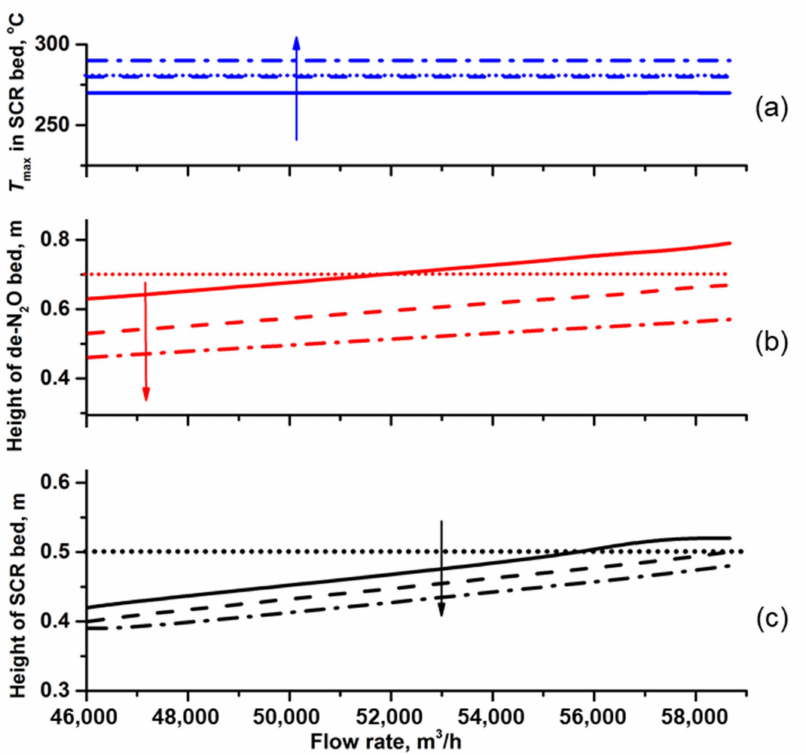
Figure 3. Maximum temperature ( a ), height of de-N 2 O bed ( b ), and height of SCR bed ( c ) vs. flow rate. T in g = 250 ◦ C (solid lines), 260 ◦ C (dashed lines), and 270 ◦ C (dash-dotted lines). The dotted lines show the maximum allowable values. The arrows indicate increasing T in g .